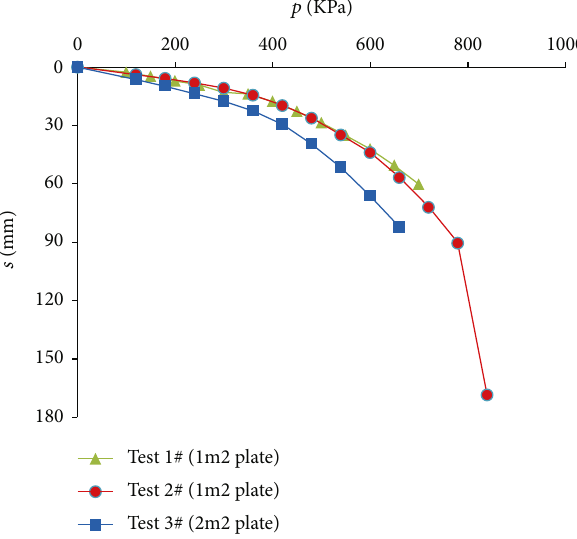
Figure 1: The p - s curves of in situ plate loading